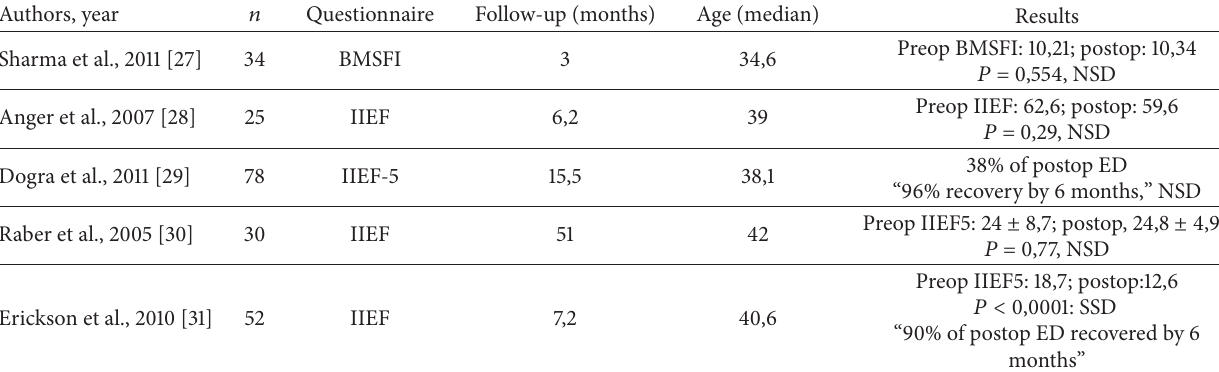
Table 1: Anterior urethra, erectile dysfunction: prospective